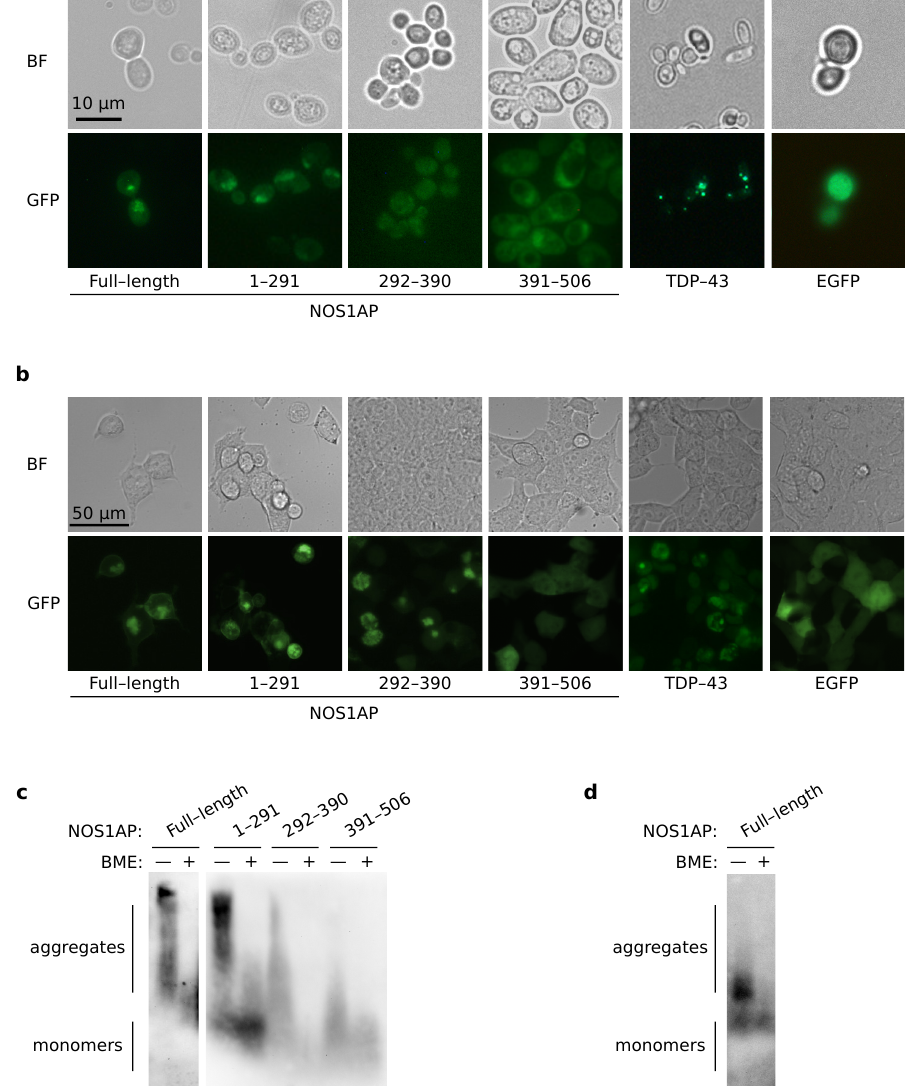
Figure 3. NOS1AP aggregates in yeasts and the HEK293T cell line. ( a ) Microphotographs of yeast cells (2-74-D694) overproducing EGFP-NOS1AP or its fragments. BF—bright field; GFP—fluorescent signal of the protein. ( b ) Microphotographs of HEK293T cells overproducing EGFP-NOS1AP or its fragments. ( c ) Results of SDD-AGE with protein lysates of HEK293T cells overproducing NOS1AP or its fragments. Anti-NOS1AP and anti-Tag(CGY)FP antibodies were used for detection of full-length NOS1AP and its fragments, respectively. ( d ) Results of SDD-AGE with protein lysates of yeast cells overproducing NOS1AP. Anti-Tag(CGY)FP antibodies were used. “+” and “–” mark sample buffers with or without BME,